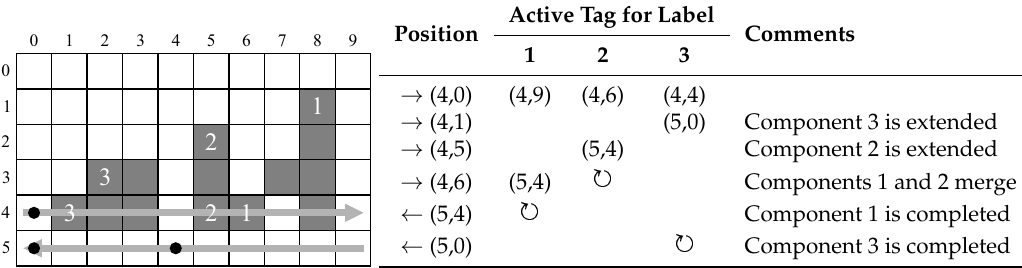
indicates when the